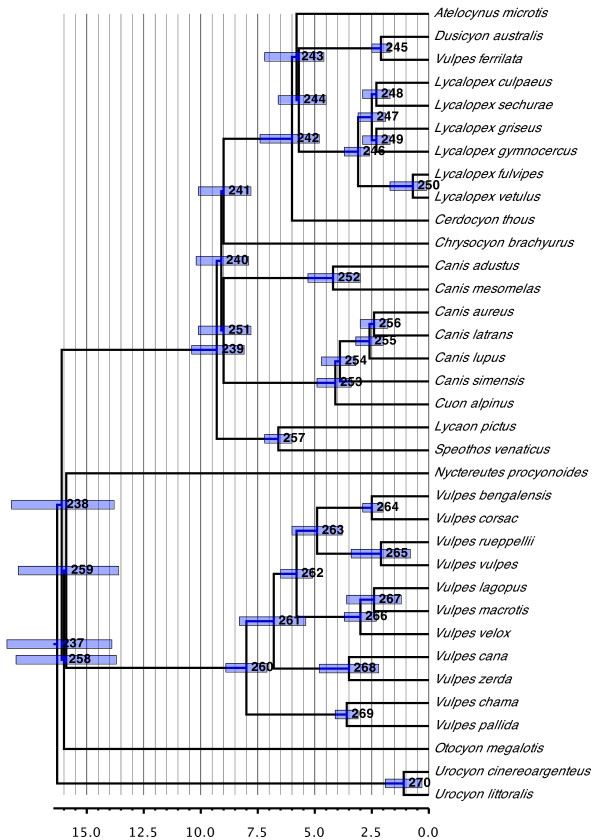
Phylogenetic relationships and divergence times estimates within Canidae. Nodes are individually numbered, with node bars indicating 95% confidence intervals on the divergence time estimates (in Ma before present).